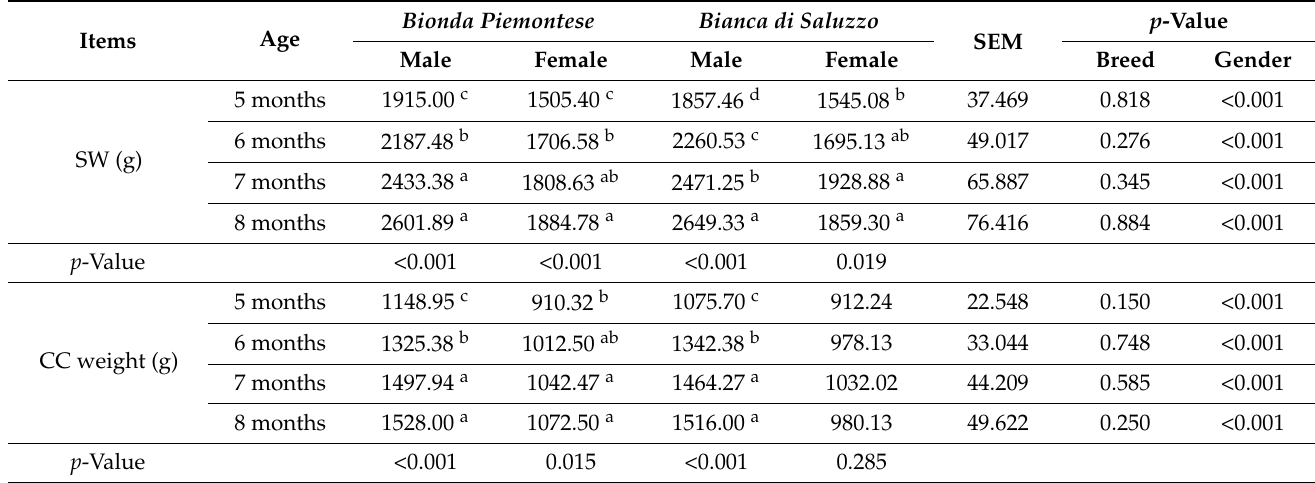
Table 1. Carcass weights of Bionda Piemontese and Bianca di Saluzzo breeds at different slaughter ages ( n = 8).